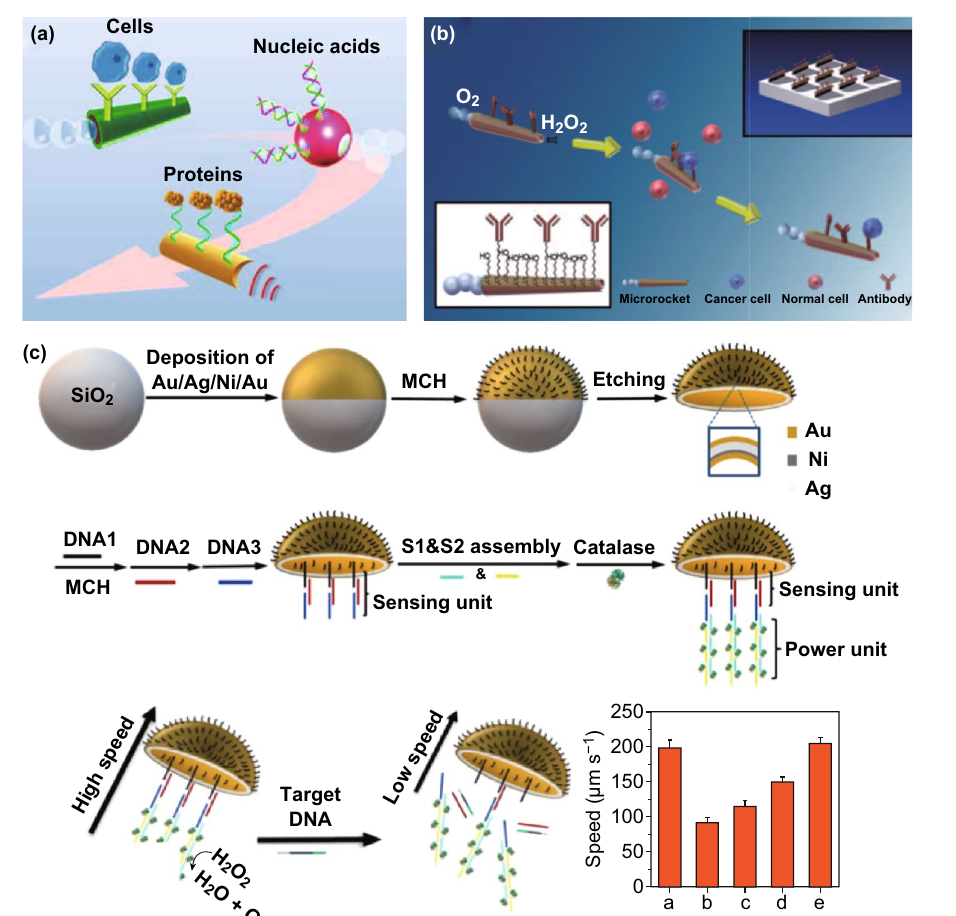
Fig. 5 Strategies and examples of micro/nanomotors for detection. a Functionalization of micro/nanorobot with different bioreceptors toward biosensing of cancer target, including cells, proteins, and nucleic acids. Adapted from Ref. [28] with permission, copyright from American Association for the Advancement of Science, 2017. b Micromotors for capture and isolation of cancer cells. Adapted from Ref. [84] with per- mission, copyright Wiley Ltd., 2011. c Schematic diagram of micromotor-based DNA sensing. Adapted from Ref. [85] with permission, copy- right American Chemical Society,